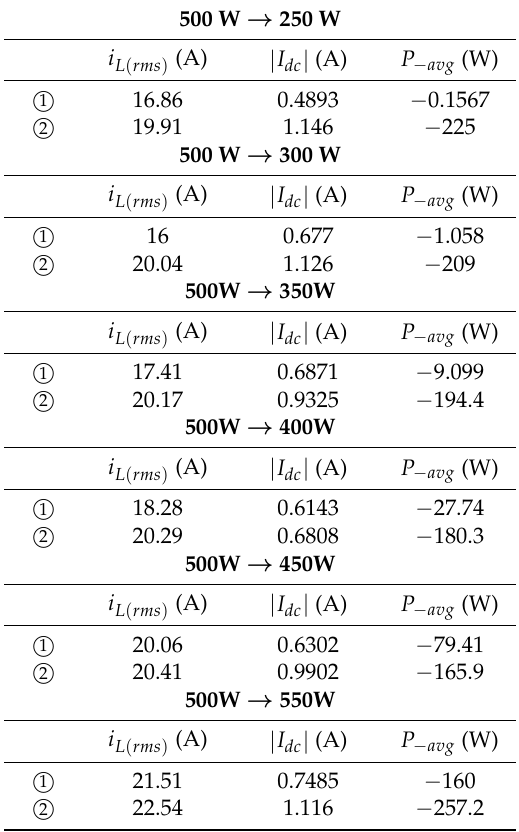
Three contrastive curves are drawn in Figure 10 from Table 3: (the transverse axis indicates a transient variation from the rated power of 500 W to the corresponding